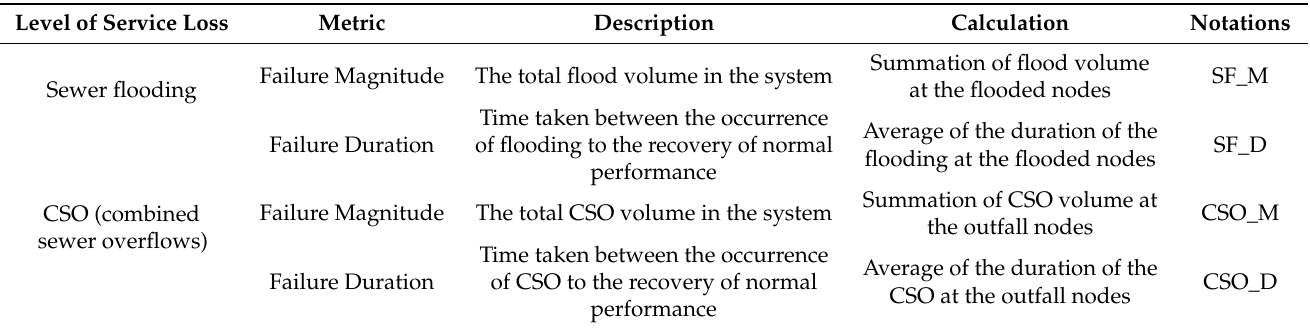
Table 2. Level of service loss measures.